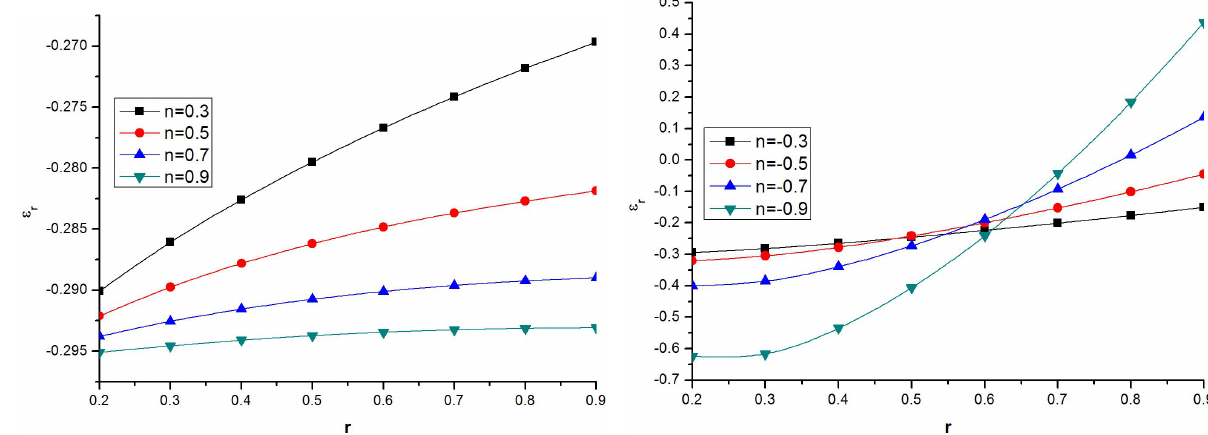
Figure 6: Variation in radial strain against radial coordinate for different values of n